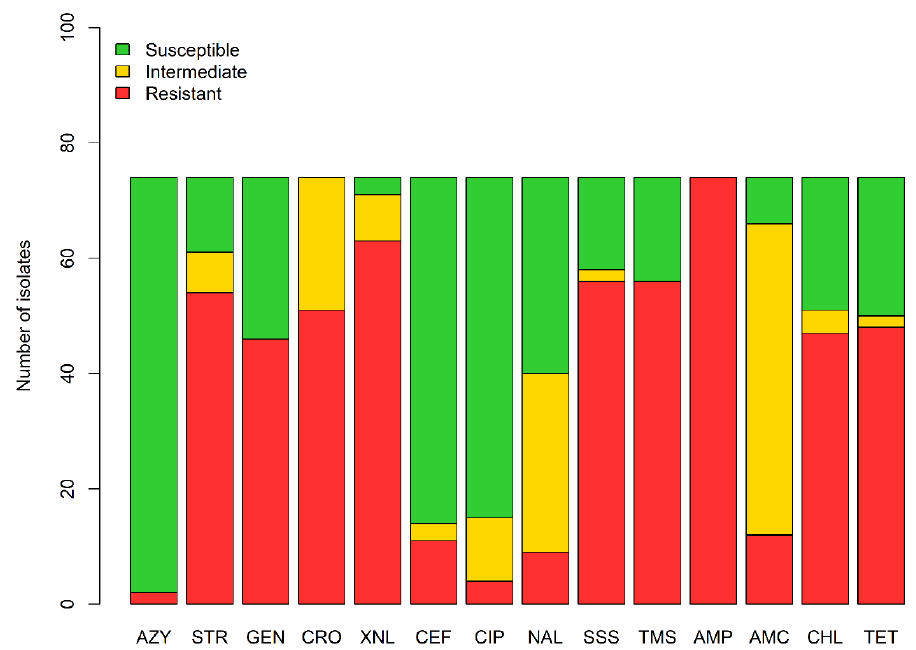
Figure 3. Susceptibility profiles of E. coli isolates in the ESBL / AmpC collection, in a cross-sectional study performed on healthy adult horses, in Quebec in 2015 and 2016 (n = 74 isolates distributed in 17 horses among 6 premises). Abbreviations: AZY = azithromycin, STR = streptomycin, GEN = gentamicin, CRO = ceftriaxone, XNL = ceftiofur, CEF = cefoxitin, CIP = ciprofloxacin, NAL = nalidixic acid, SSS = sulfisoxazole, TMS = trimethoprim–sulfamethoxazole, AMP = ampicillin, AMC = amoxicillin / clavulanic acid, CHL = chloramphenicol, TET =